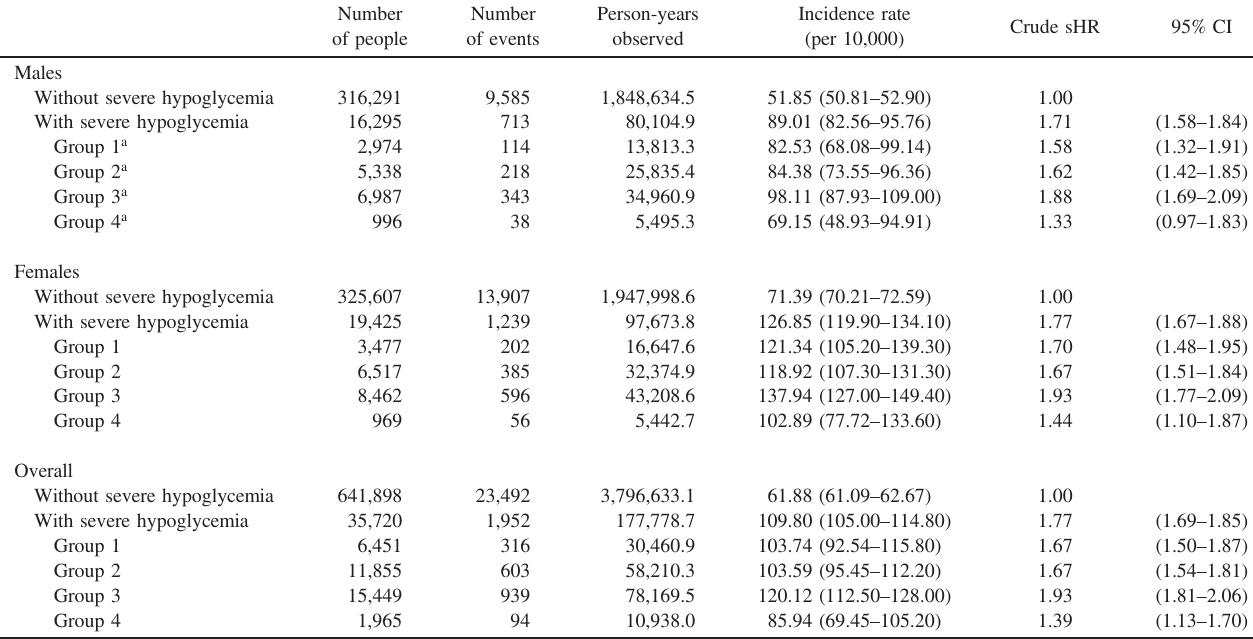
Table 2. Incidence rates and crude subdistribution hazard ratios of dementia diagnosis in relation to groups by severity of severe hypoglycemia trajectory for patients with type 2 diabetes Number Number Person-years of people of events observed